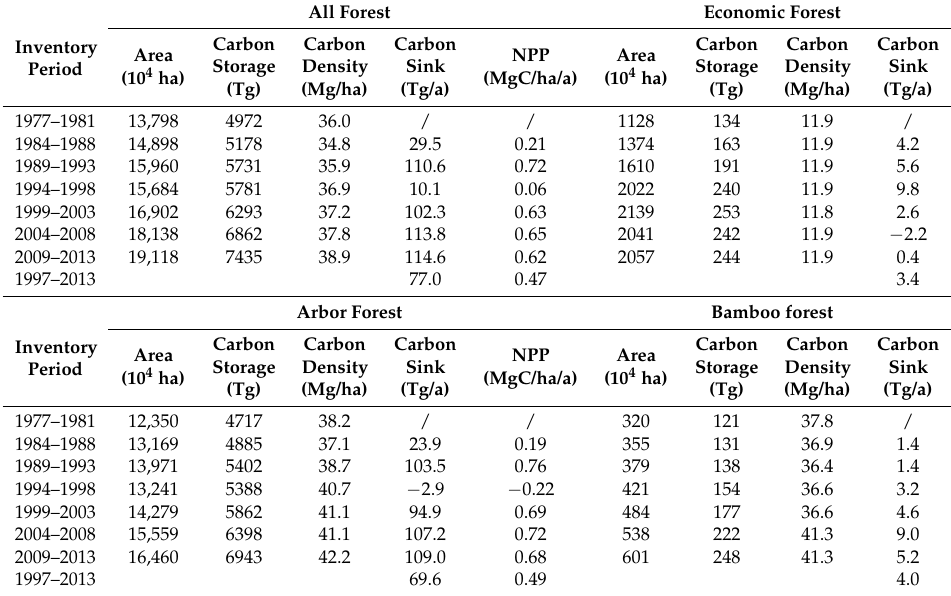
Table 2. Changes in forest area, biomass carbon storage, density, carbon sink and net primary productivity (NPP) in China for seven five-year intervals over the period 1977–2013 and pooled carbon sink estimates for the period 1997–2013 (last row). Empty cells for the period 1977–1981 represent data